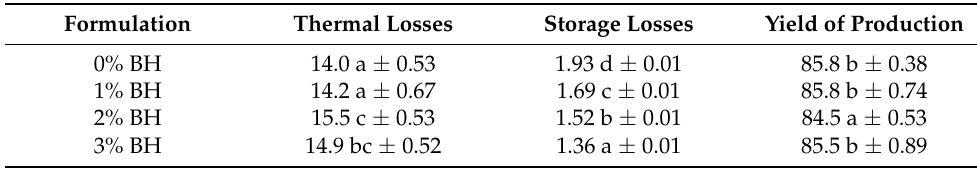
Table 2. Effect of BH on thermal and storage losses and yield of production